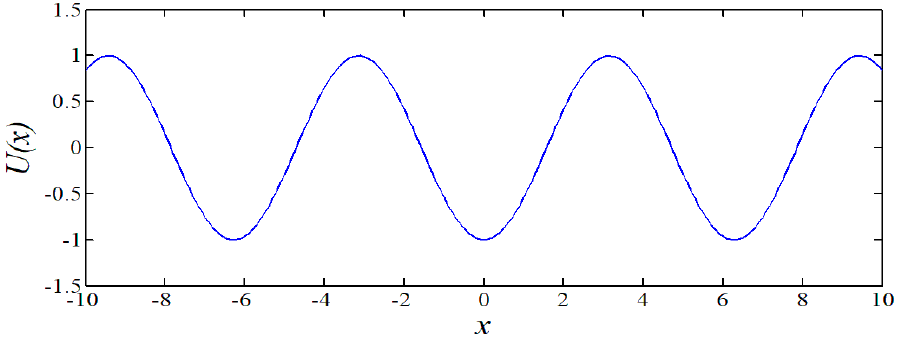
Figure 1. Periodic potential function.